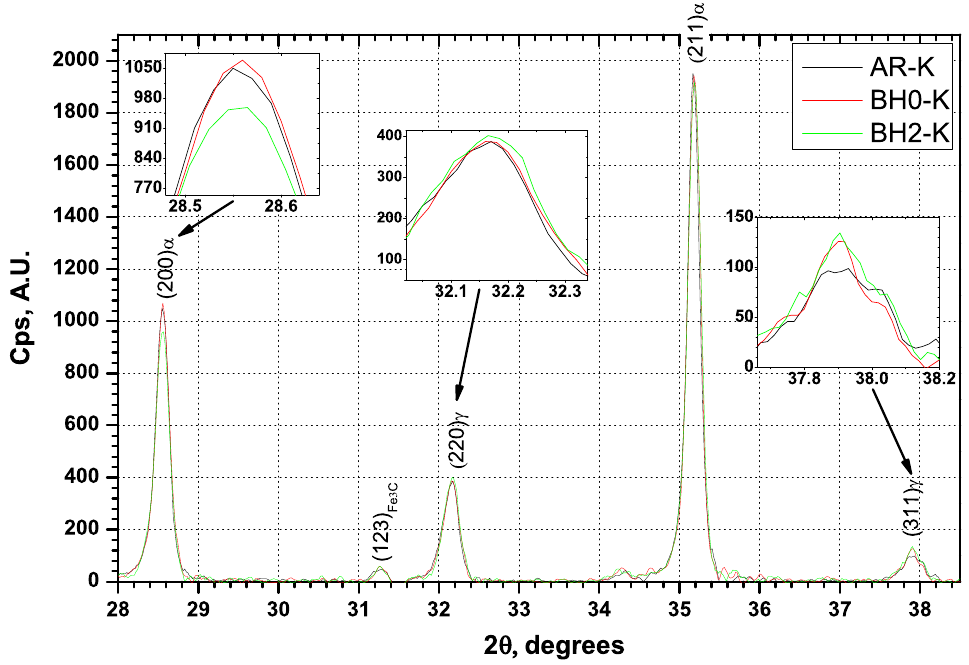
Figure 12. X-ray diffraction diffractogram showing the effect of the bake-hardening and prestraining for the TRIP5 steel (BH 0 , paint-baking at 170 ◦ C/20 min; BH 2 , 2%prestrain, paint-baking at 170 ◦ C/20 min).